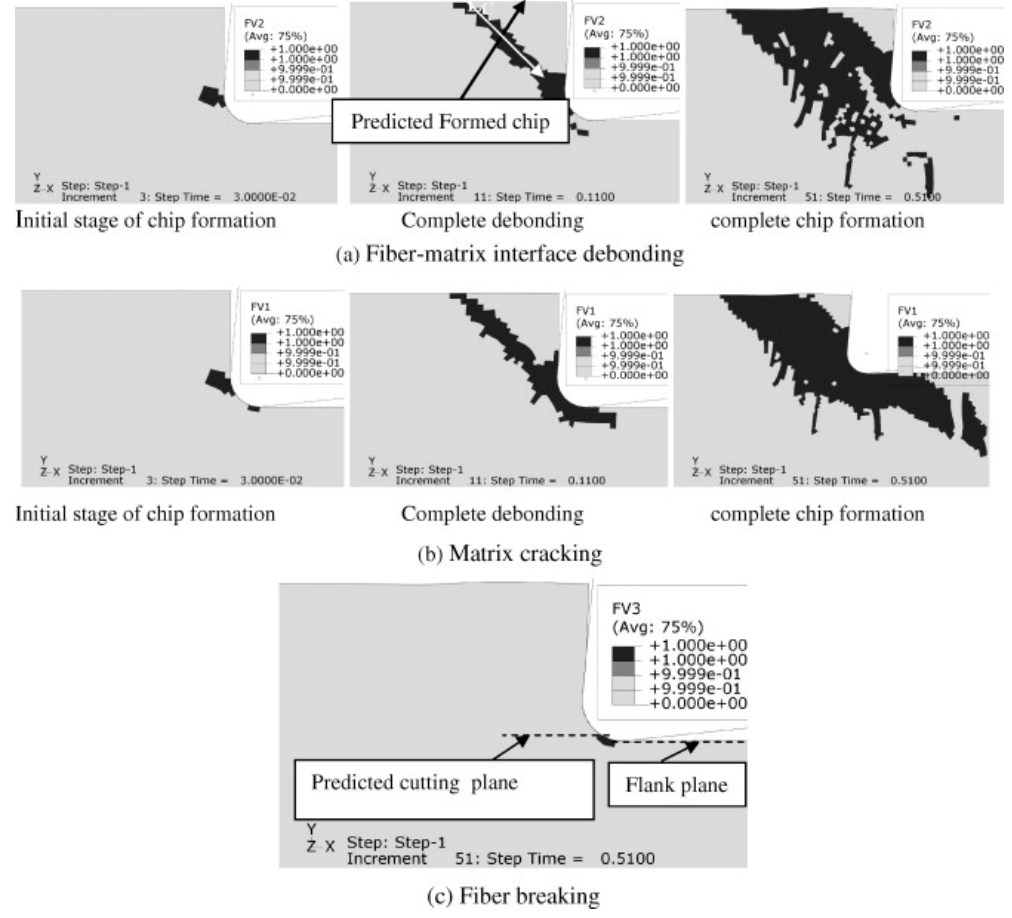
Figure 15 . Progressive failure analysis with Hashin failure criteria for 45° fiber orientation. ( a ) Fiber–matrix interface detachment, ( b ) matrix fracture and ( c ) fiber rupture. Reproduced with permission [24].